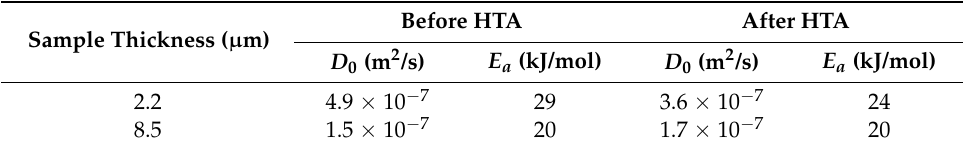
Table 3. Estimated values of the pre-exponential factor ( D 0 ) and of the activation energy ( E a ) for 2.2 µ m and 8.5 µ m thick membranes before and after the main HTA sequence.